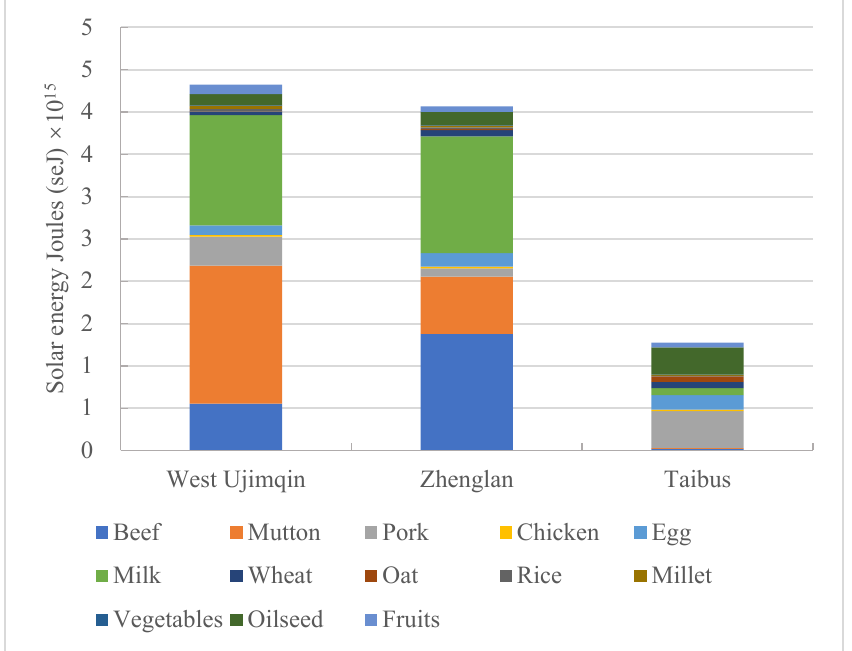
Figure 2. The structure of food consumption in the three banners.